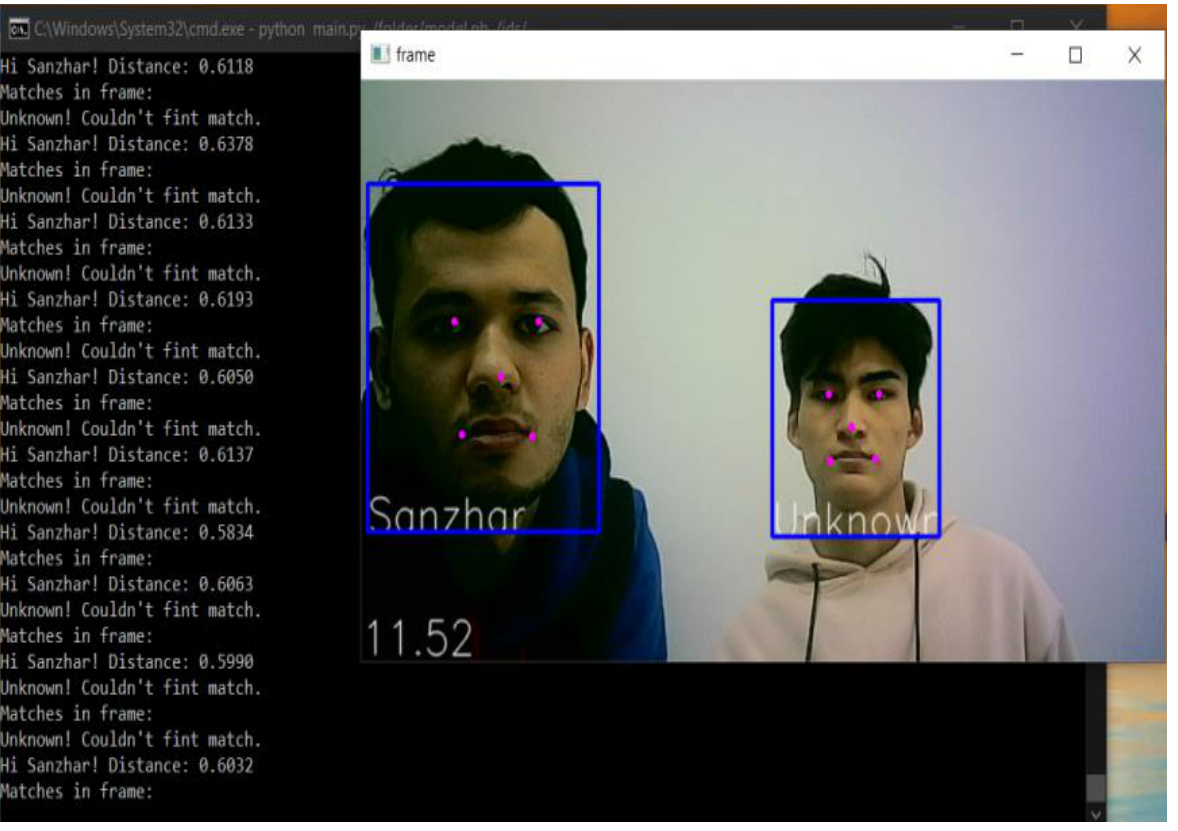
Figure 6. Object identification in the video